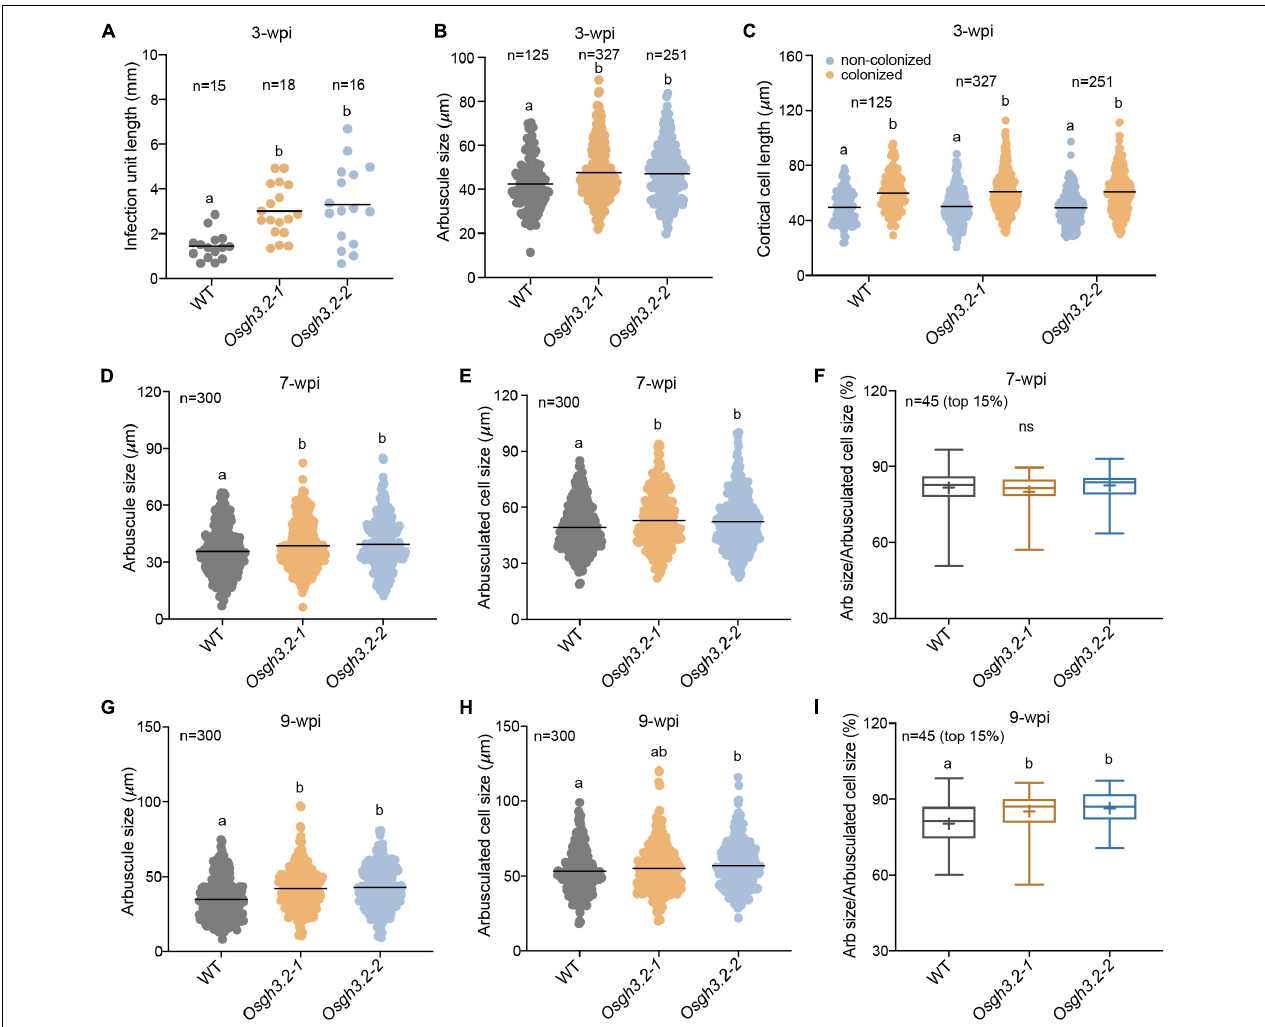
FIGURE 5 | Osgh3.2 mutants showed larger arbuscules as well as enlarged arbuscule-containing cortical cells at 7- and 9-wpi. (A) Lengths of infection units in wild-type and the Osgh3.2 mutants at 3-wpi by R. irregularis. Data are individual values from at least 15 individual infection units from three biological replicate samples of wild-type and Osgh3.2 mutants. (B) Data represent arbuscule sizes (longitudinal length) of wild-type (125 arbuscules), Osgh3.2-1 (327 arbuscules), and Osgh3.2-2 (251 arbuscules) at 3-wpi from all the measured infection units in (A) . (C) The measured longitudinal lengths of colonized and neighboring non-colonized cortical cells in wild-type (125 cells each), Osgh3.2-1 (327 cells each), and Osgh3.2-2 (251 cells each) at 3-wpi. (D,G) For either wild-type rice or the Osgh3.2 mutants, the longitudinal lengths of 300 arbuscules from three rice individuals were measured. (E,H) The longitudinal lengths of cortical cells containing arbuscules in wild-type and the Osgh3.2 mutants at 7- and 9-wpi, respectively. Data represent individual values of 300 colonized cells from three biological replicate samples of wild-type and Osgh3.2 mutants. (A–E,G,H) The horizontal line shows the mean value. Statistical analysis was performed with Student’s t -test. Different letters indicate statistically significant differences ( P < 0.05). (F,I) When only the 15% largest arbuscules were considered, the longitudinal length ratios of arbuscules to cortical cells were shown in box plots and compared between wild-type and the mutants. The boxes represent the variation between the first and third quartiles; the “ + ” indicates mean value, and the horizontal line indicate the median. Statistical analysis was performed with Student’s t -test (ns, not significant; different letters indicate statistically significant differences, P < 0.05).